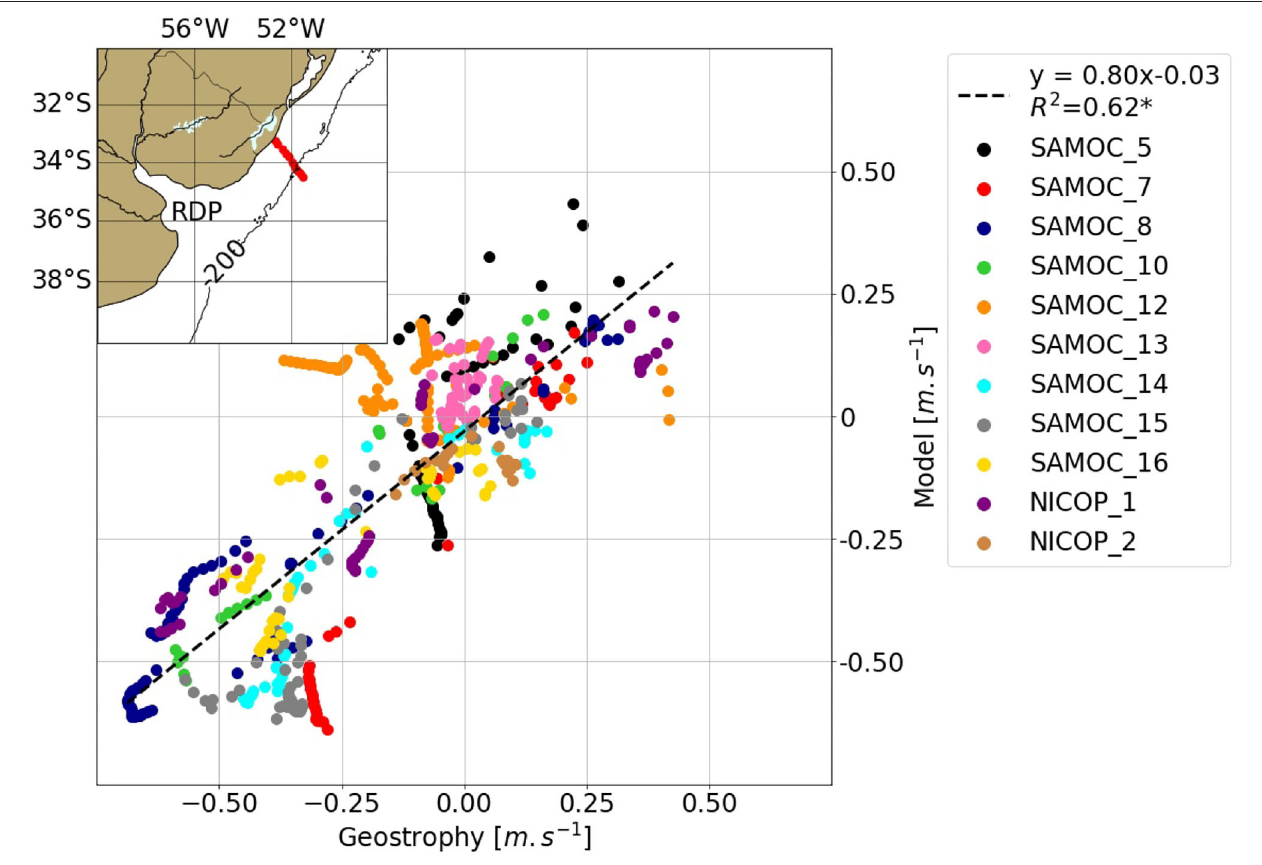
FIGURE 2 | Model vs. geostrophic velocities with a vertical resolution of 10 m during 12 oceanographic surveys over the Albardão section. The dashed line indicates the linear fit to the data. Inset: Location of Albardão transect (red line). The 200 m isobath is indicated by a gray line.